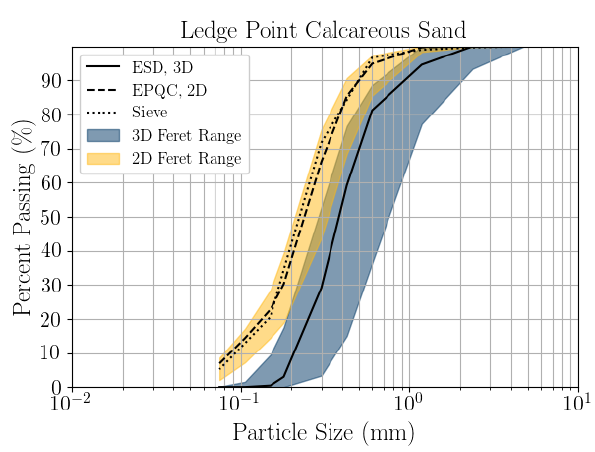
Figure 4. Particle size distribution for Ledge Point from 3D µ CT and DIA.